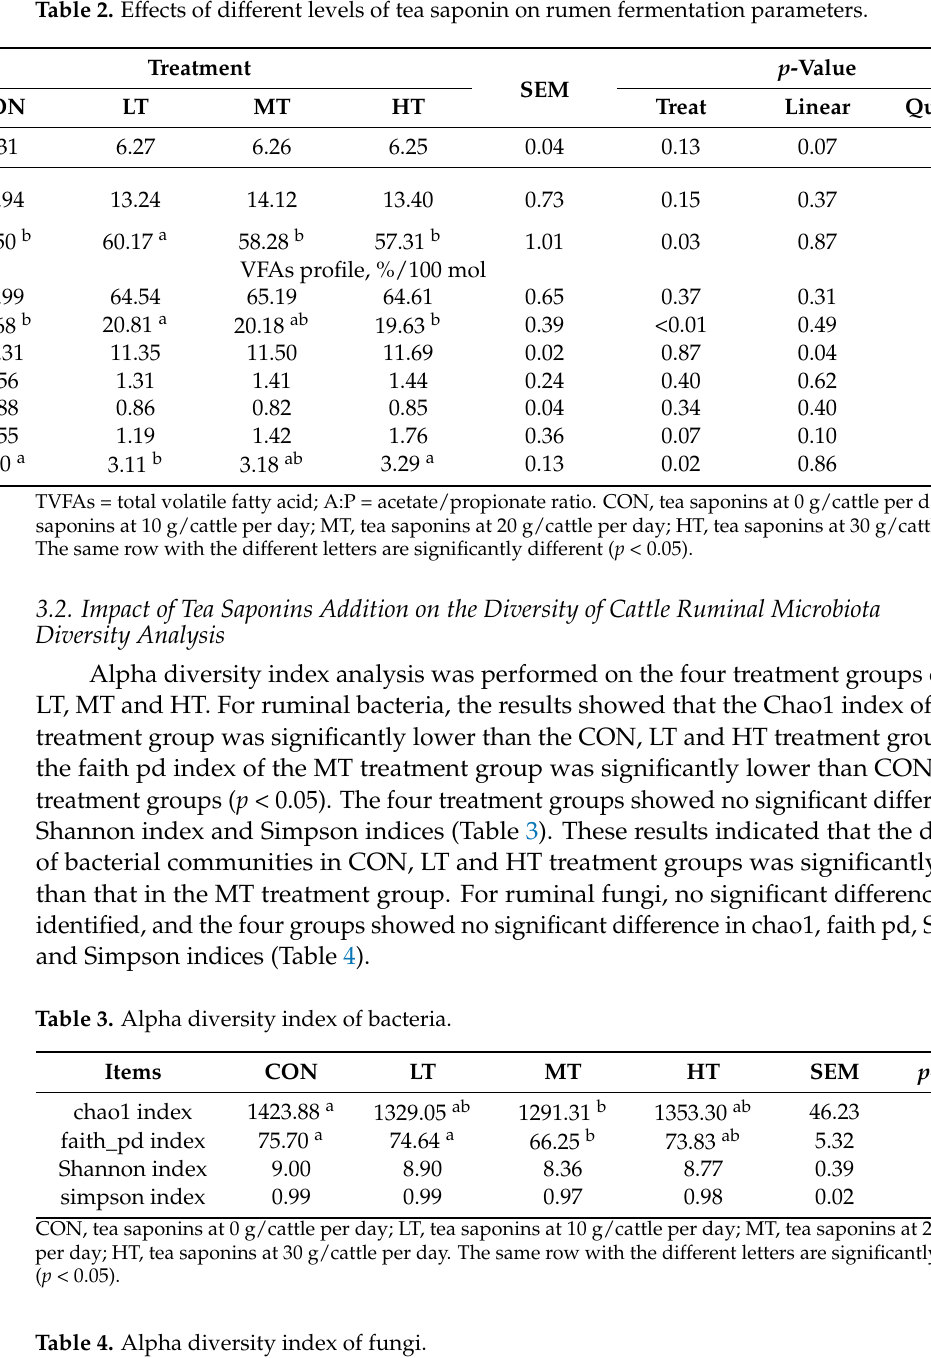
Table 2. Effects of different levels of tea saponin on rumen fermentation parameters.